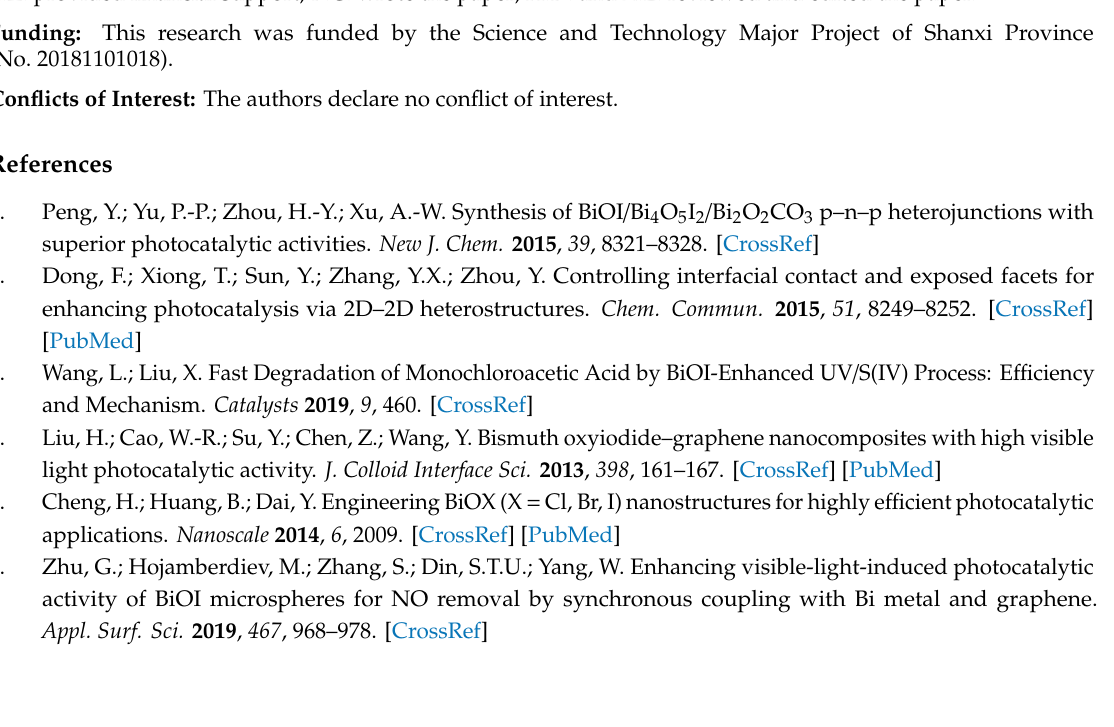
Figure S1: SEM images and EDS analysis of as prepared samples in di ff erent locations: (a), (b) I-poor bismuth oxyiodide, (c), (d)BiOI, Figure S2: The energy band structure of Bi 3 O 5 I 2 and BiOI, Table S1: The elemental composition of I-poor bismuth oxyiodide, Table S2: The elemental composition of BiOI, Table S3 Photocatalytic activity of di ff erent